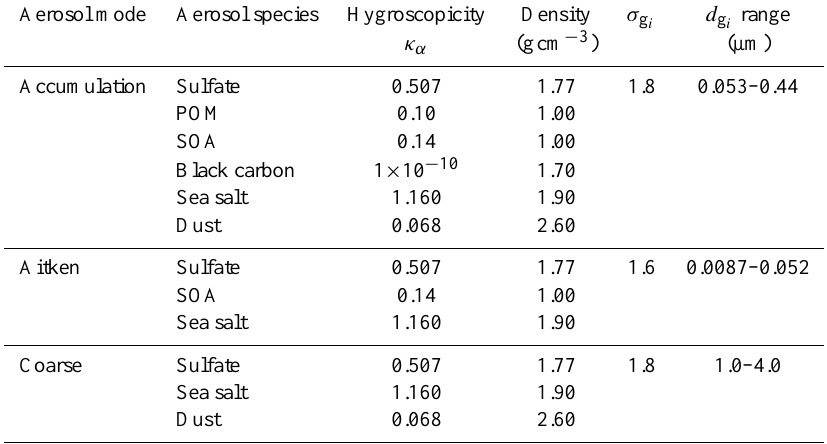
Table 1. Aerosol species and size distribution parameters in MAM3 used as input for the cloud droplet number activation parameterizations. d g is the geometric mean diameter (µm), and σ g i